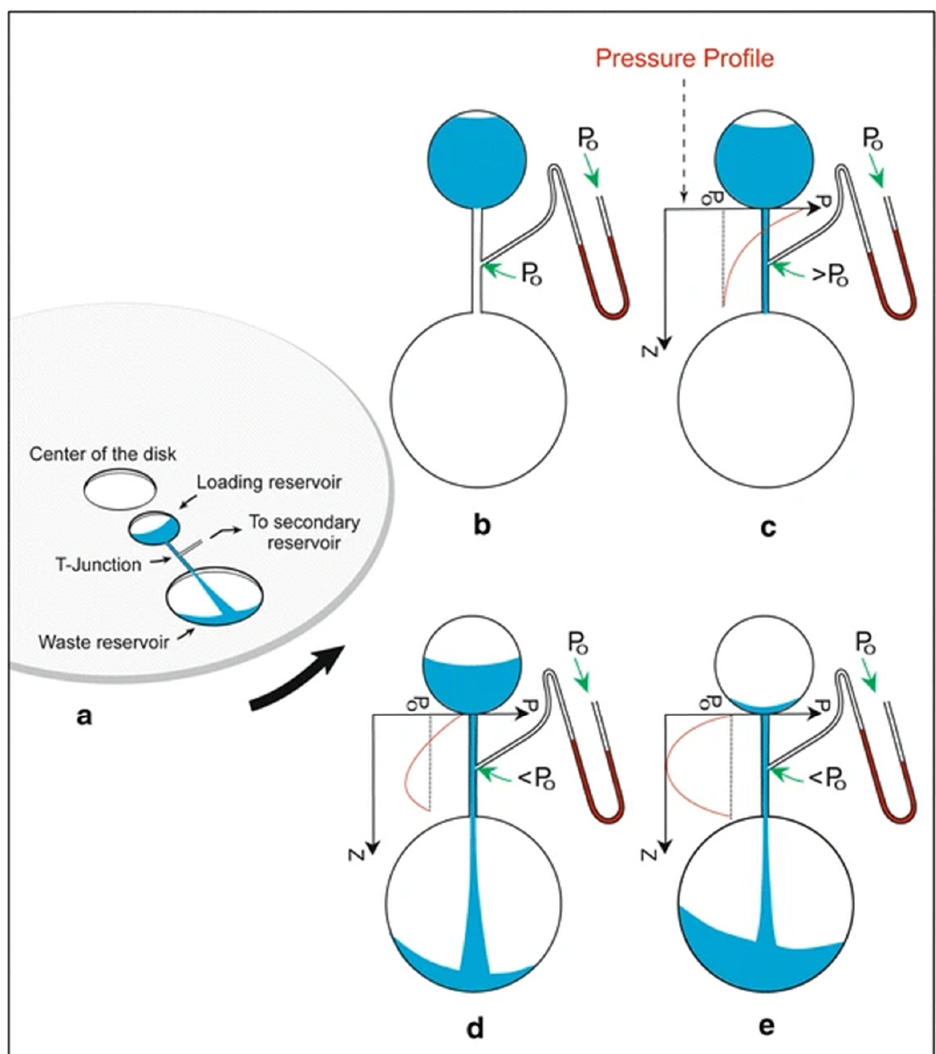
Figure 8. Schematic demonstrating the action of the suction-enhanced capillary valve on a centrifugal platform. ( a ) A view of the centrifugal microfluidic structure; ( b – e ) pressure profile changes in